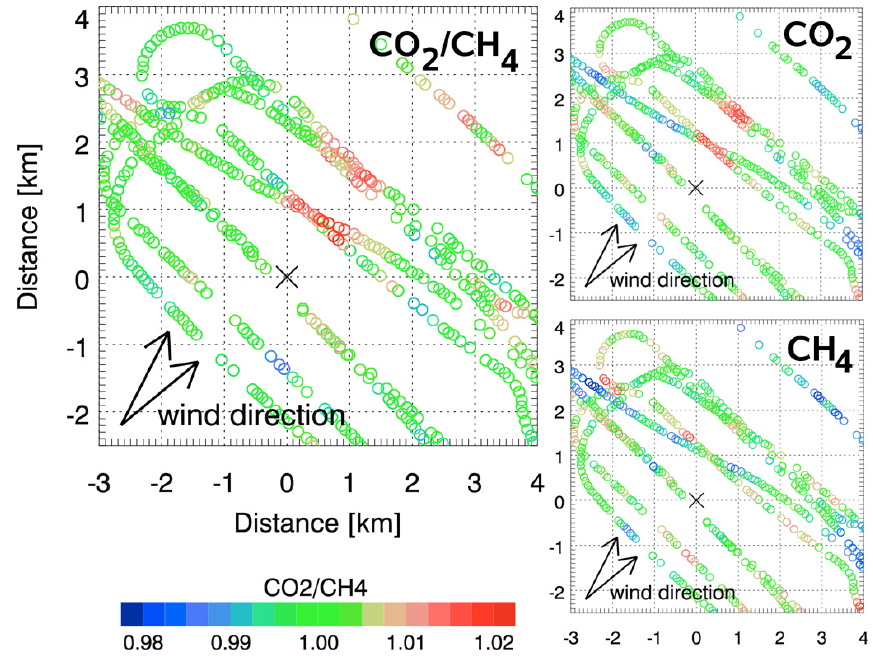
Fig. 13. Same as Fig. 12 but for Schwarze Pumpe power plant. Again the power plant emission plume is already clearly visible in the CO 2 measurement (i.e. before the ratio CO 2 /CH 4 is